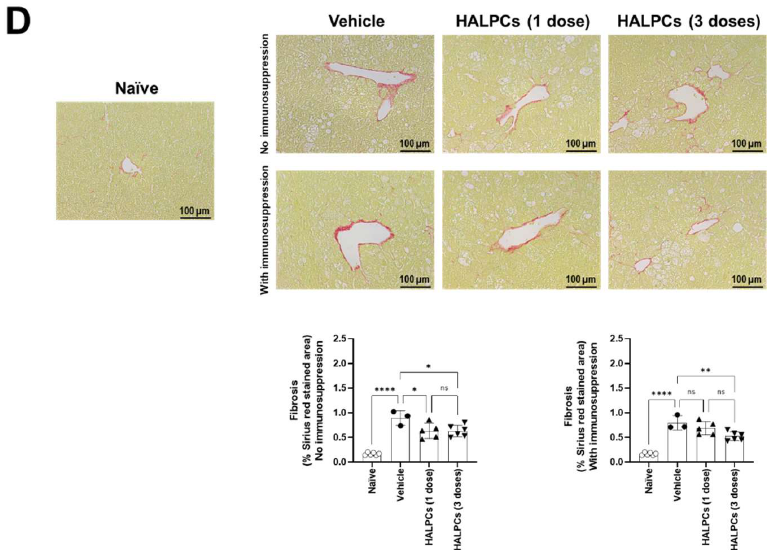
Figure 5. Evaluation of HALPC transplantation efficacy in early-stage NASH mouse model. Serum CRP was quantified by Mouse High-Sensitive CRP ELISA kit on non-fasting serum from the different mice groups. ( A ) Without immunosuppression regimen. ( B ) With immunosuppression regimen. ( C ) Representative photomicrographs of HE-stained liver sections. NAFLD Activity score (NAS) was calculated according to the criteria of Kleiner [30]. ( D ) Representative photomicrographs of Sirius red-stained sections. Bright field images of Sirius red-stained sections were captured around the central vein using a digital camera at 200-fold magnification, and the positive areas in 5 fields/sections were measured using ImageJ software (National Institute of Health, USA). ns: not significant; *: p < 0.05; **: p < 0.01; ***: p < 0.001; ****: p < 0.0001 (Tukey Multiple Comparison Test).